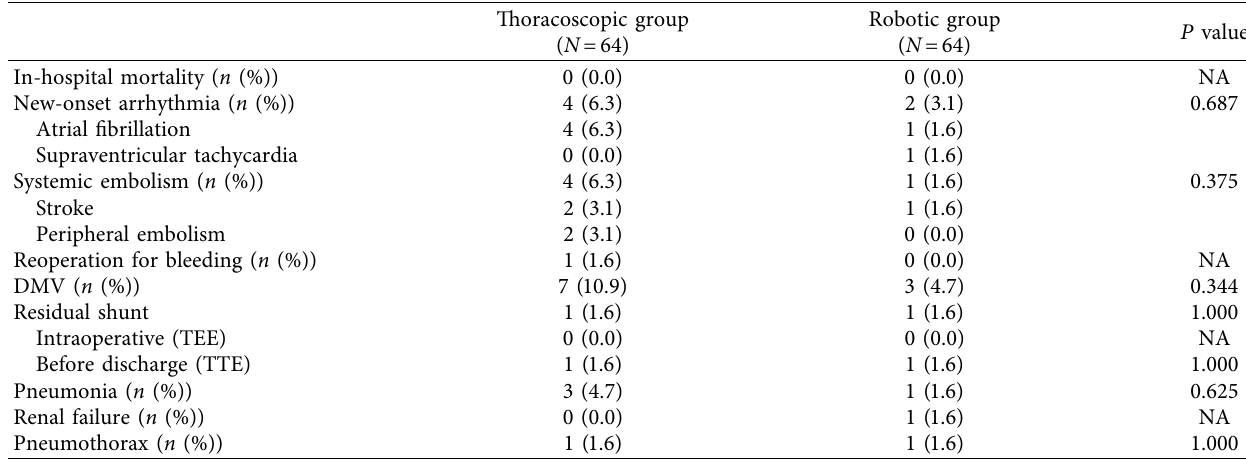
Table 4: In-hospital complications (propensity-matched